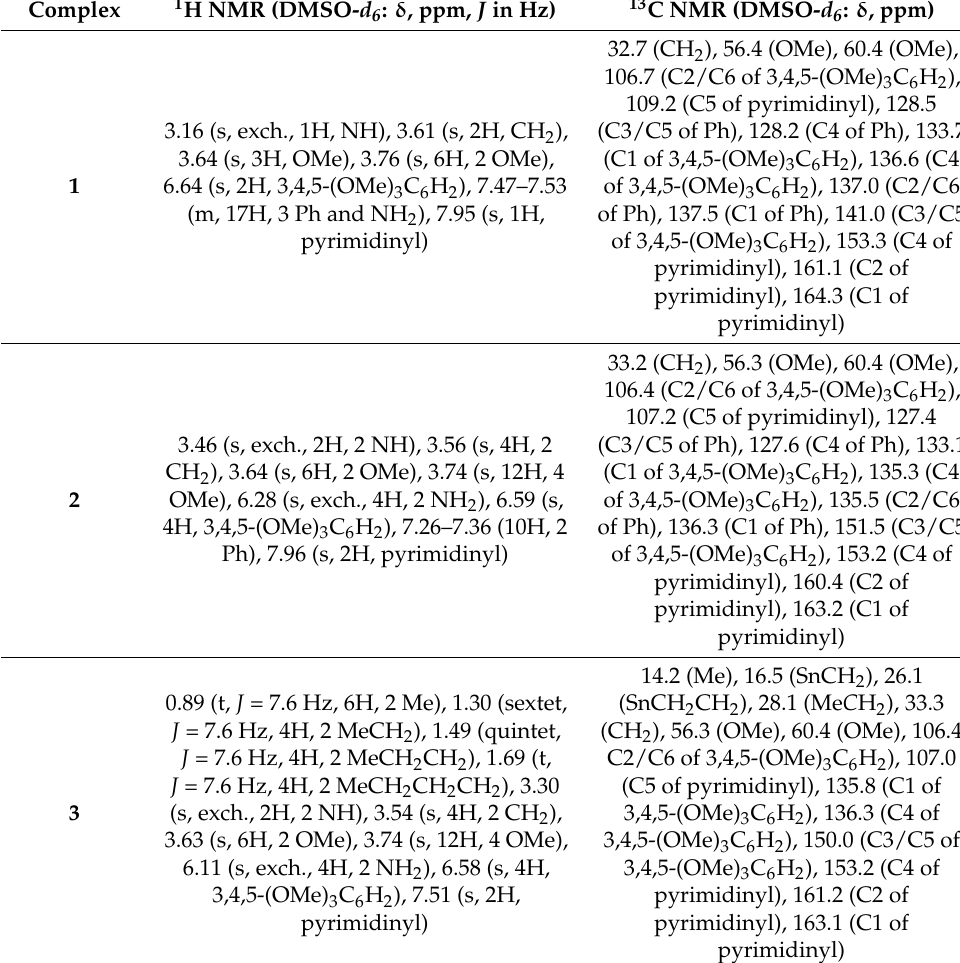
Table 3. NMR spectral data of trimethoprim–tin complexes 1–3